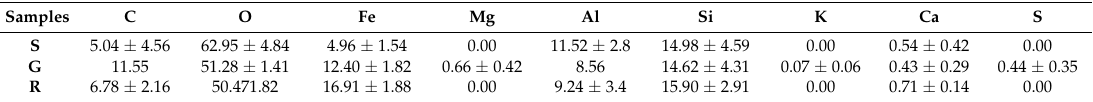
Table 2. Energy-dispersive X-ray spectroscopy analysis of cave sediment (S), gravel-like (G), and rock (R) samples. Values in % followed by the standard deviation.